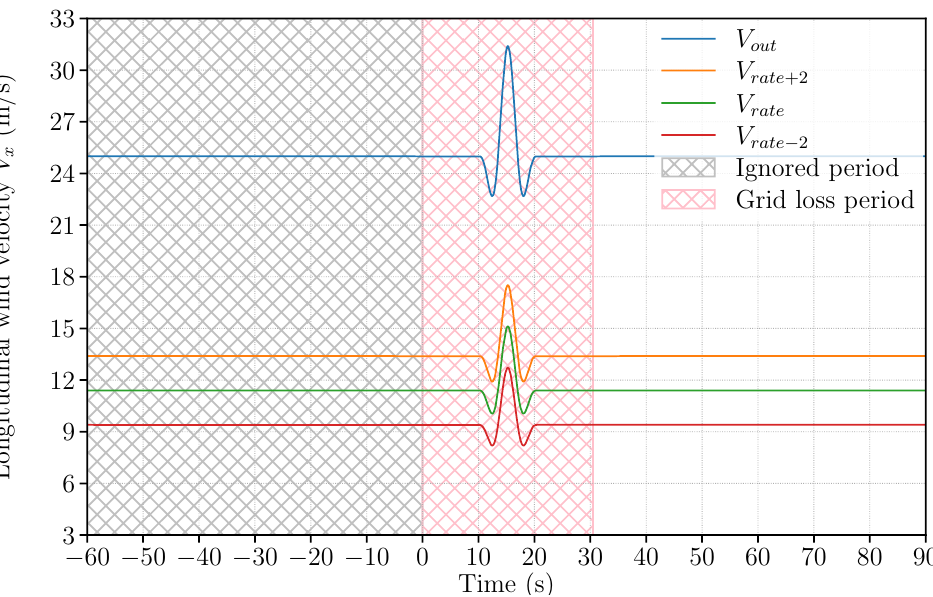
Figure 4. Wind velocity at hub height in longitudinal direction with Extreme Operating Gust (EOG).